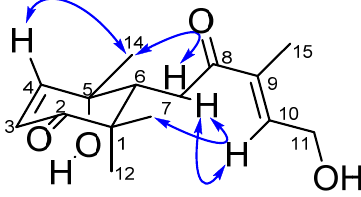
Figure 3. Some ROESY correlations of 4.